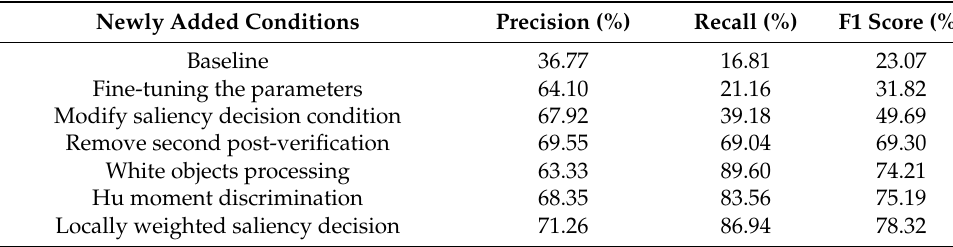
Table 3. Ablation experimental results. Only a new idea is added on the basis of the previous experiment while the other conditions remain unchanged.